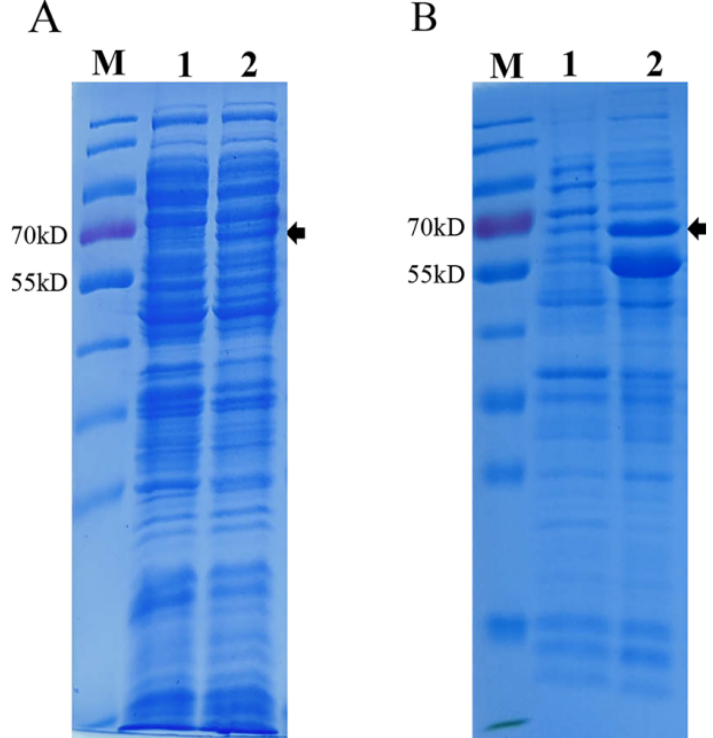
Figure 1. SDS-PAGE analysis of PPV VP2 protein expression in E. coli. ( A ) Coomassie staining of PPV VP2 protein expressed in E. coli without chaperone pTf-16. ( B ) Coomassie staining of PPV VP2 protein in E. coli co-expressed with chaperone pTf-16. M. Marker. Lane 1, Coomassie staining of PPV VP2 protein before IPTG and L-Arabinose induction. Lane 2, Coomassie staining of PPV VP2 protein after IPTG and L-Arabinose induction.